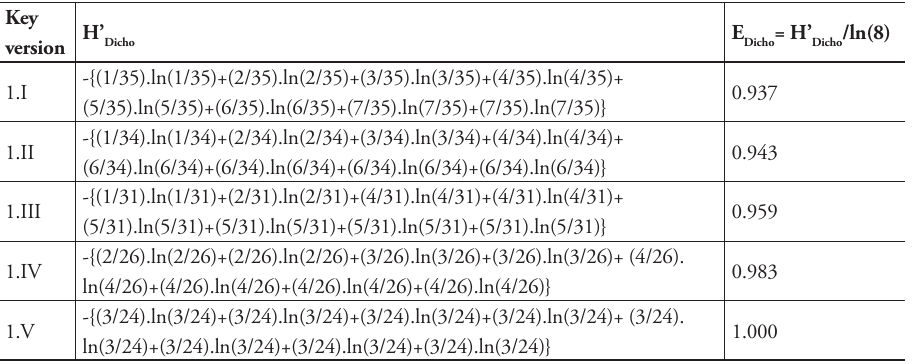
Table 2. Calculation of H’